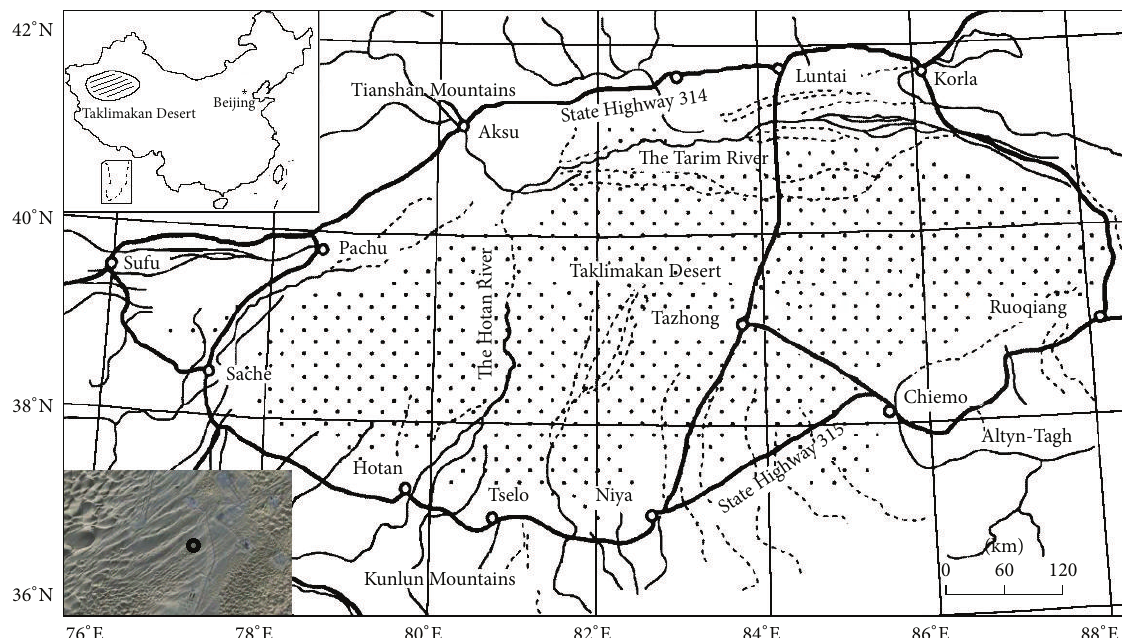
Figure 1: The Taklimakan Desert and the location of the Tazhong station within the Tarim depression. In the satellite photograph, the black circle is the location of the observational site, it shows that Tazhong area is mainly covered by dunes, and the site is located on a flat sandy land.